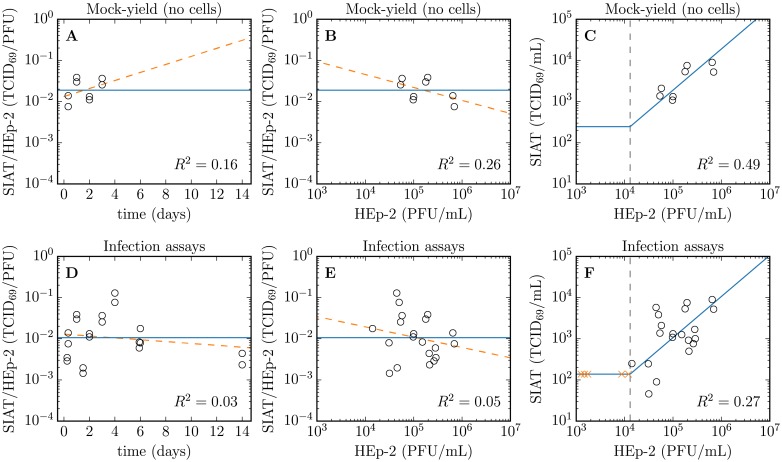
Measures of RSV infectivity on SIAT and HEp-2 cells.Comparison of the infectivity of individual RSV samples as measured on SIAT cells in TCID69/mL compared to that measured on HEp-2 cells in PFU/mL for each sample. The SIAT/HEp-2 infectivity ratio is shown (A) as a function of incubation time in the mock-yield (no cells) assay; or (D) as a function of infection time in the infection assays; or (B, E) as a function of the sample’s infectivity when quantified on HEp-2 cells. The solid horizontal line in (A, B, D, E) corresponds to the geometic (logarithmic) mean of the infectivity ratio (SIAT/HEp-2), and the comparative dashed line corresponds to a log-lin (A, D) or log-log (B, E) linear regression with associated R2 value provided. (C, E) RSV sample infectivity quantified on SIAT cells is shown as a function of that on HEp-2 cells in the mock-yield (C) and infection (F) assays. The solid diagonal line indicates the expected relationship between SIAT and HEp-2 and points should fall along this line. The ‘×’ denote samples with a measurable infectivity on HEp-2 cells (their x-value) that was undetectable on SIAT cells. These points were placed at what appears to be the limit of infectivity detection in SIAT cells, which corresponds to an infectivity of 1.3 × 104 PFU/mL in HEp-2 cells, indicated by a vertical dashed line. The data shown here are the same as those shown again as a function of time in Figs 2 and 4.